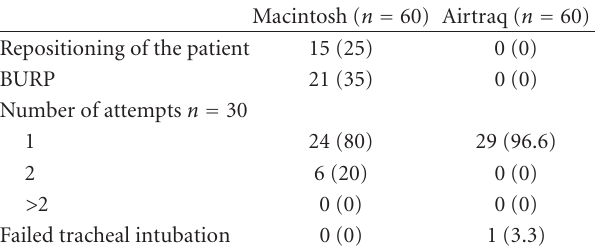
Table 4: Airway optimization maneuvers in the patients using the Airtraq and the Macintosh laryngoscopes. Data are shown as abso- lute numbers (percentage). BURP: back, up, right,